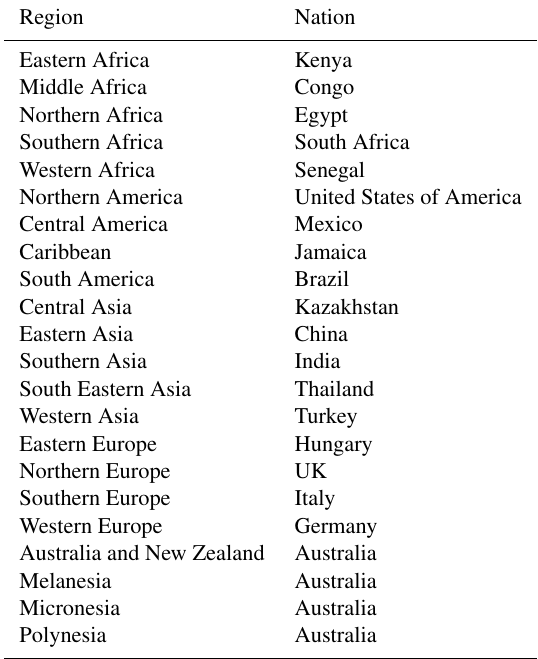
Table A1. Food and Agriculture Organization of the United Nations (FAO) regions and the country for which complete groundwater in- formation was obtained from IGRAC